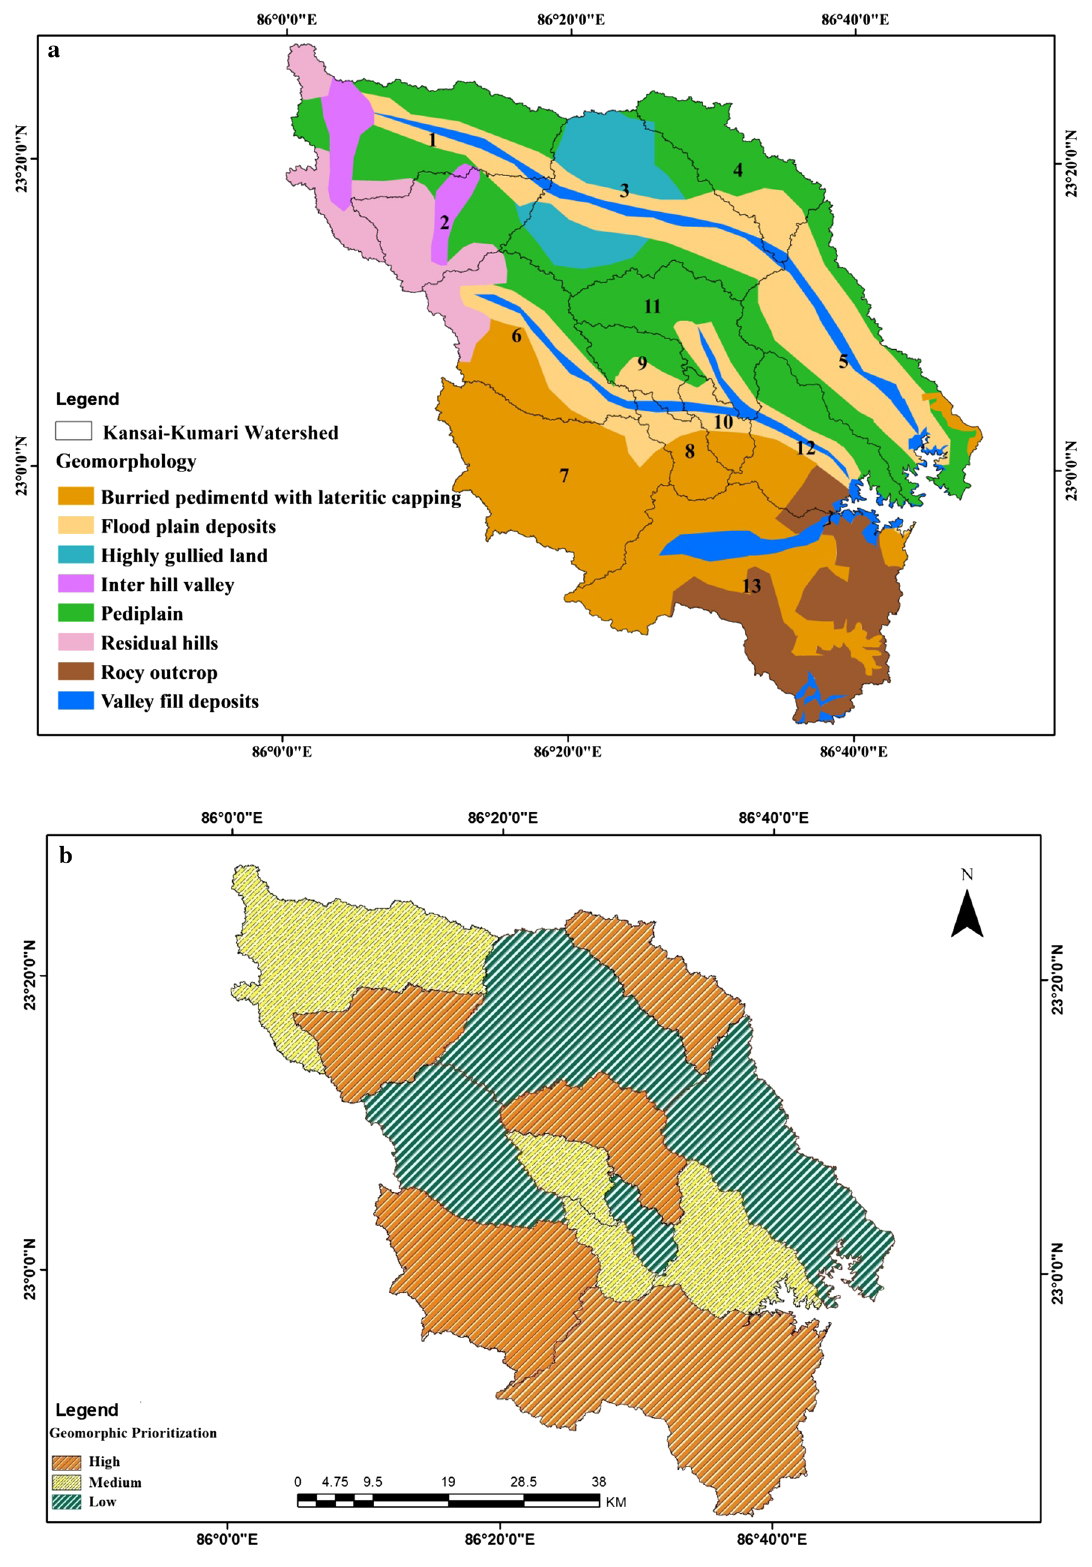
Fig. 5 a Geomorphic set up in Kansai–Kumari reservoir catchment area and b priority based on geomorphic parameters analysis in Kansai– Kumari reservoir catchment